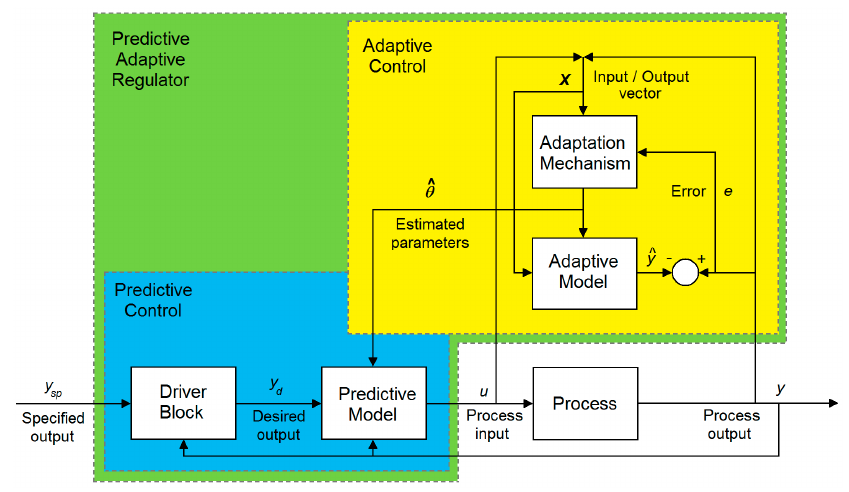
Figure 8. Adaptive-predictive control implemented.